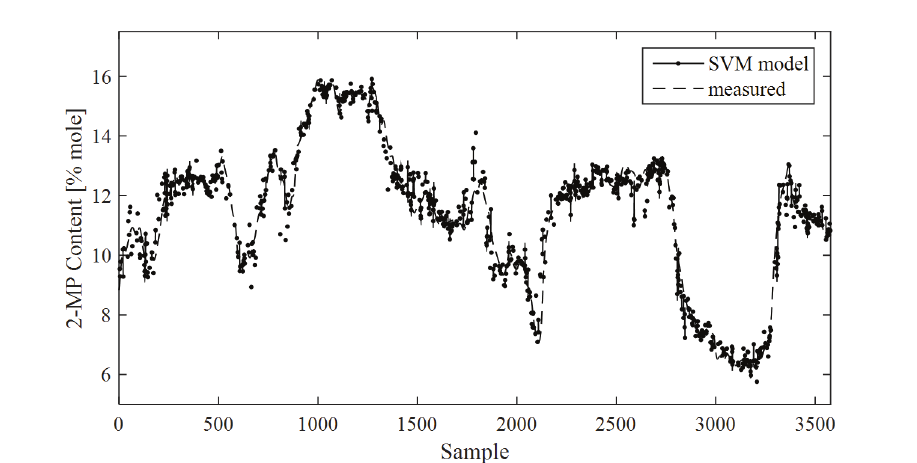
Fig. 11 – Comparison between measured data and 2-MP content SVM model results